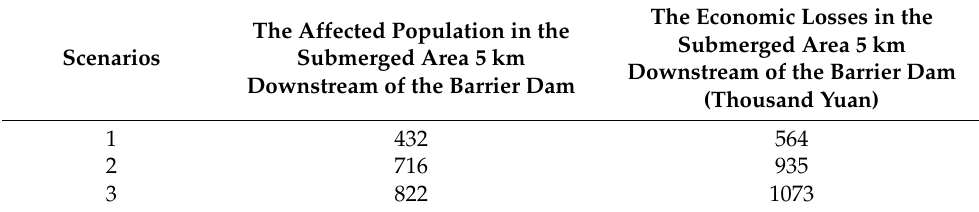
Table 9. Disaster-affected population and economic losses under different